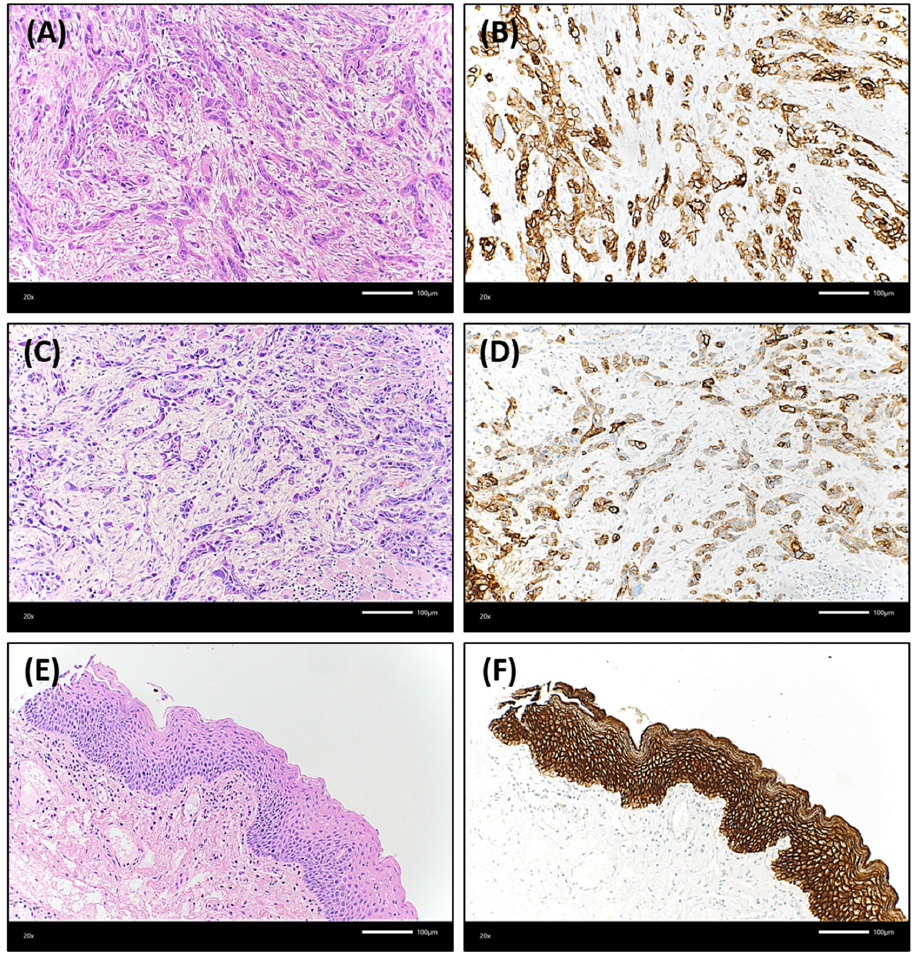
Figure 3. Illustration of an OSCC case that showed a lower Trop-2 expression in both the central and peripheral tumor regions compared to non-neoplastic oral mucosa. Both ( A ) central and ( C )